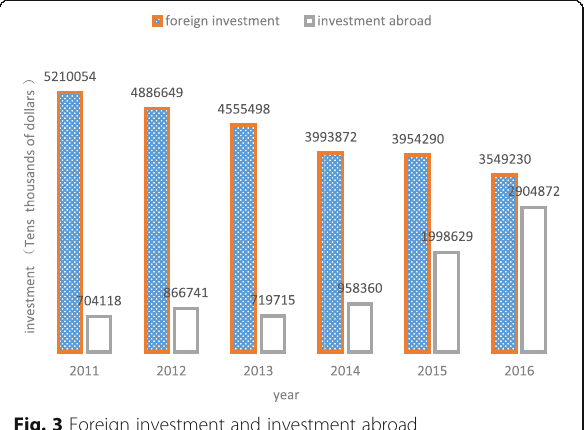
Fig. 3 Foreign investment and investment abroad